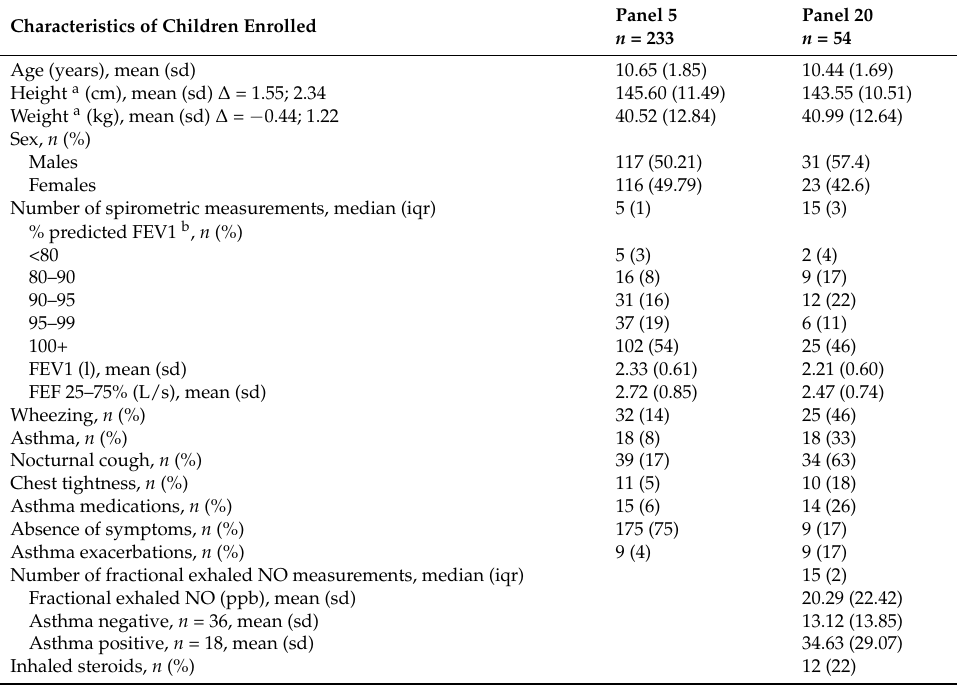
Table 1. Descriptive statistics for children enrolled in the panel studies in Sarroch (Sardinia), Italy (January–June 2007). Characteristics of Children